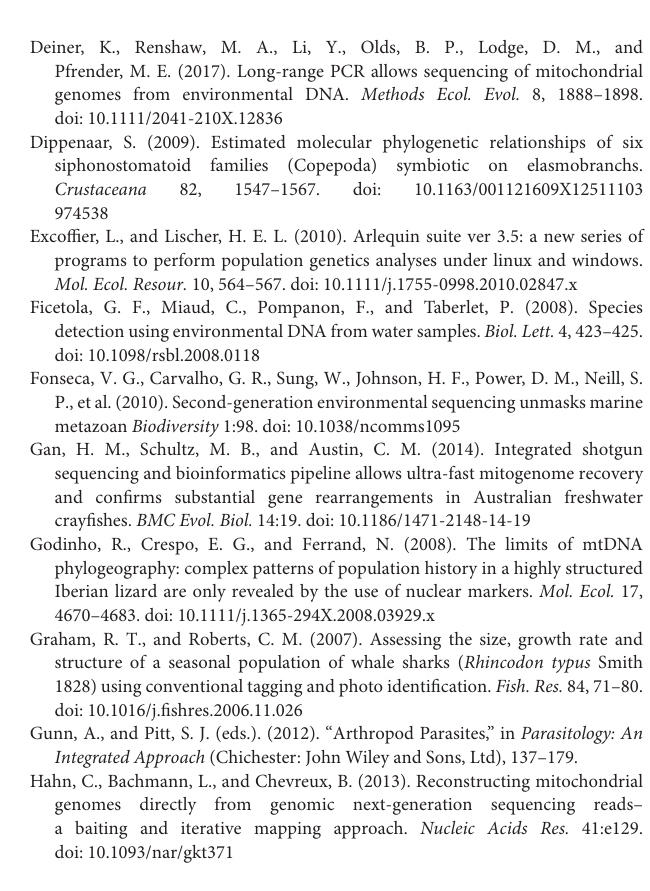
Supplementary Table 1 | Sample collection information. Supplementary Figure 1 | Visualization of aligned control region sequences (one representative from each study). Arrows indicate regions upstream and downstream of the 5 ′ and 3 ′ ends, respectively, that will be trimmed off for subsequent haplotype clustering. Supplementary Figure 2 | Bowtie2 alignment of Illumina reads generated from copepod gDNA to the whale shark genomic region containing 18S and 28S nuclear rRNA genes. Red and blue arrow bars indicate forward and reverse pair-end reads, respectively. Supplementary Data 1 | Cd-hit clustering of trimmed whale shark control region sequences that were amplified from copepods. Supplementary Data 2 | Alignment of whale shark control region sequences. Supplementary Data 3 | Trimmed alignment of whale shark control region sequences based on the conserved region depicted in Supplementary Figure 1. Supplementary Data 4 | Cd-hit Clustering of trimmed whale shark control region sequences. Supplementary Data 5 | Paired-end reads mapped to the whale shark genomic region containing the 18S and 28S ribosomal RNA